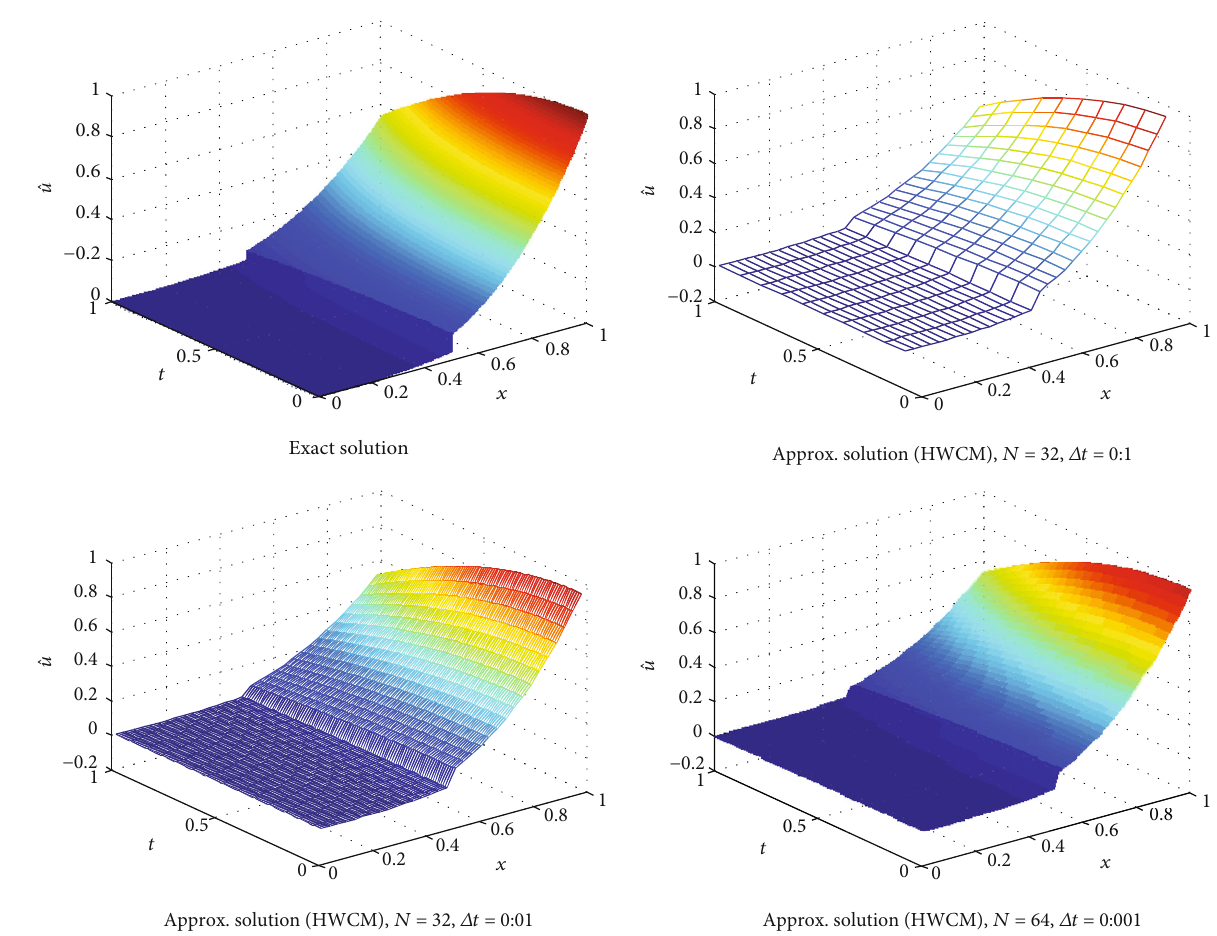
Figure 3: Comparability of exact and estimated results for Example